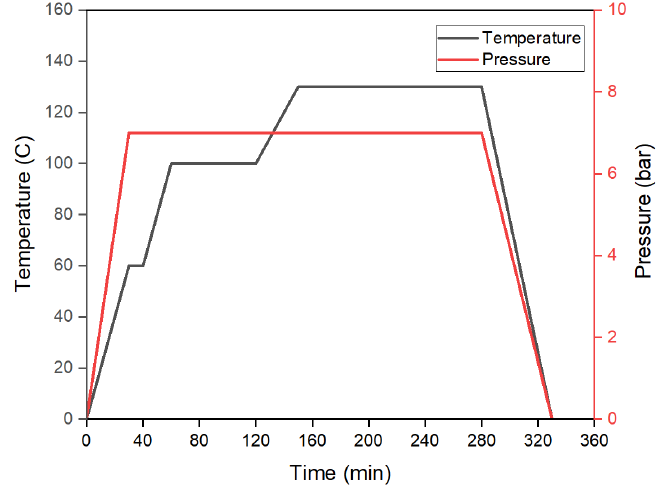
Figure 5. T700 carbon fiber/epoxy material curing cycle for 38 mm thick